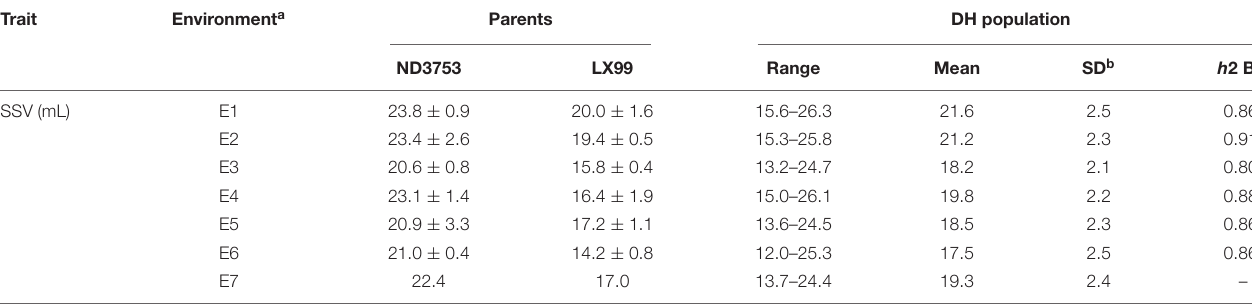
TABLE 1 | Descriptive statistics of two parents and DH population for SDS-sedimentation volume (SSV) under seven environments. Trait Environment a